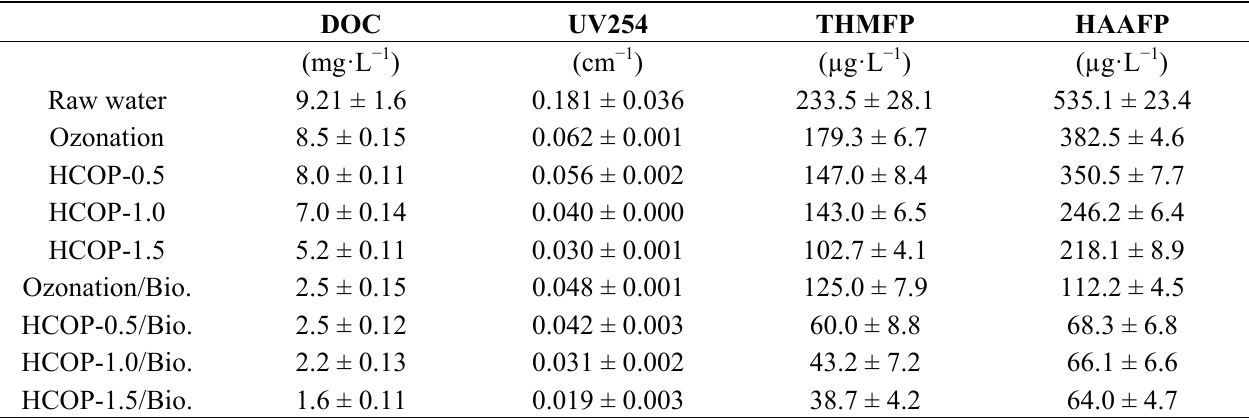
Table 3. Concentrations of water quality parameters and disinfection by-product formation potential (DBPFP) in different experimental conditions. UV254, ultraviolet absorbance at 254 nm; THM, Trihalomethane; HAA, haloacetic acid.